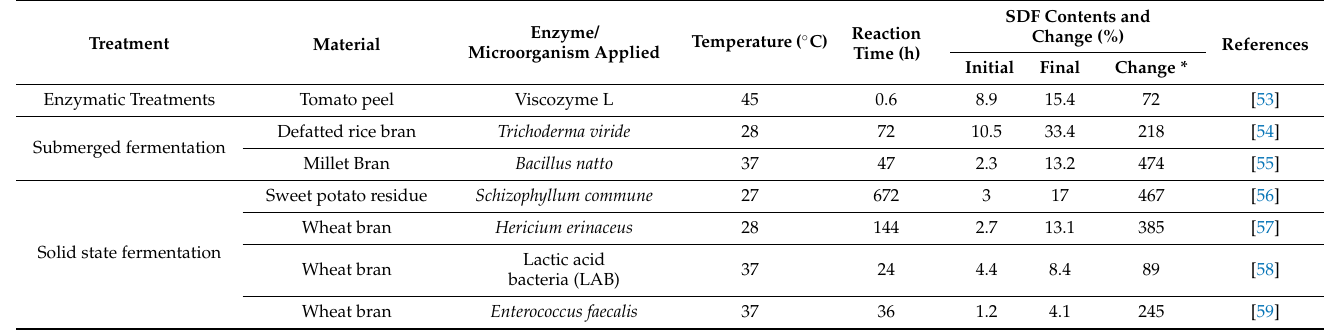
Table 6. Some examples of biological treatment methods applied to influence the DF composition. (SDF content is related to total initial mass, values marked by * are related to total dry